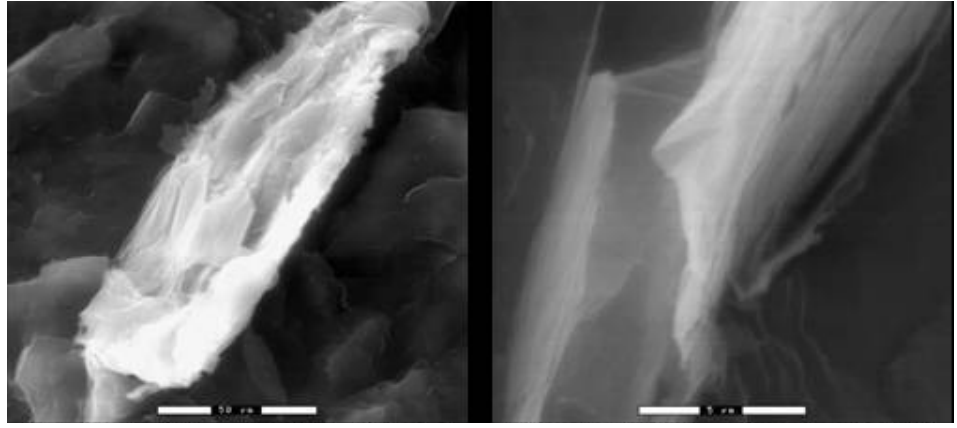
Figure 2. ESEM images of fracture surface of 1 vol % xGnP-15/PP (a) xGnP-15 agglomerates (scale bar 50  m) and (b) xGnP-15 “roll-up” (scale bar 5 